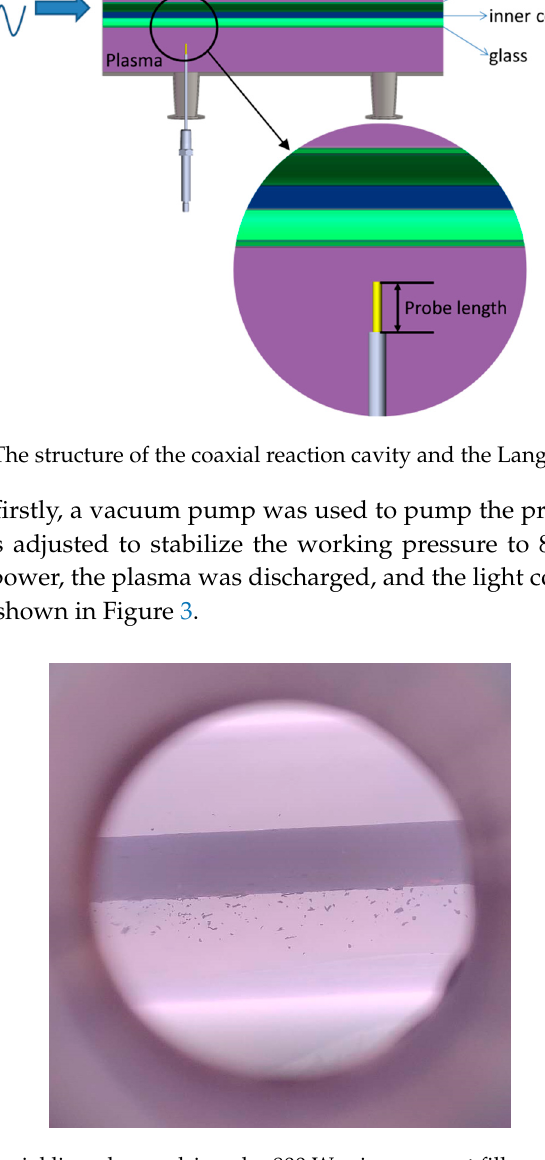
Figure 3. Coaxial line plasma driven by 800 W microwave at fill pressure of 80 Pa.